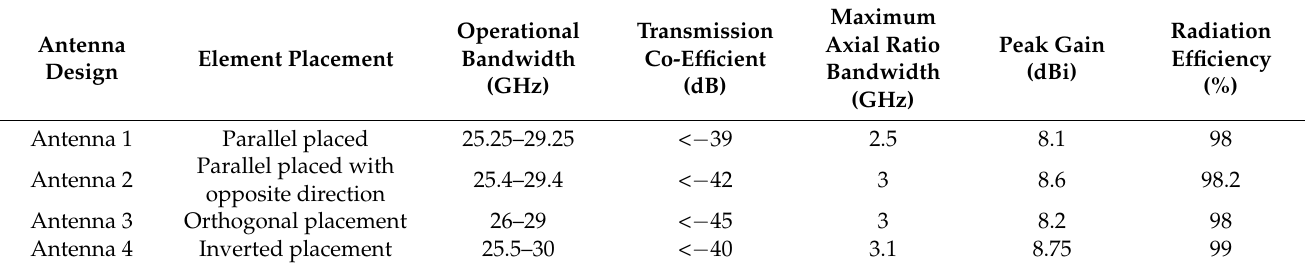
Table 1. Performance comparison of various MIMO